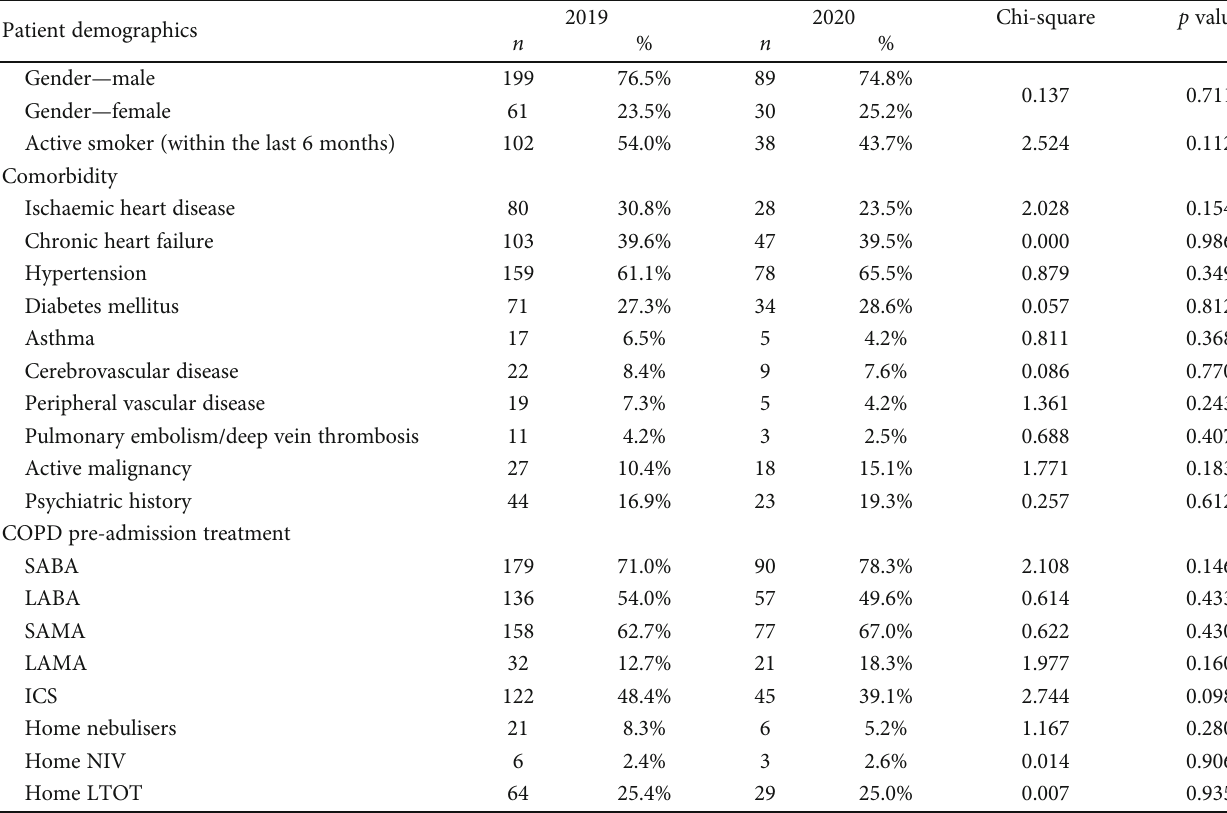
Table 1: Demographics and comorbidities of patients hospitalised with AECOPD and COPD pre-admission treatment. Patient demographics